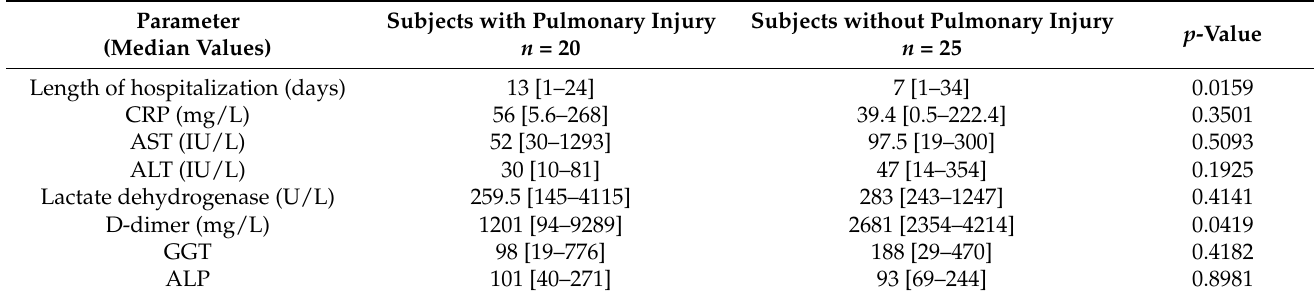
Table 2. The impact of pulmonary injury on laboratory findings.